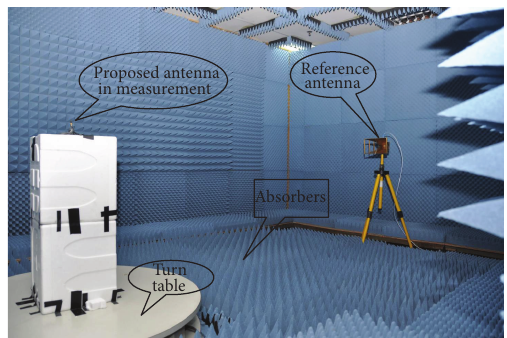
Figure 3: Illustration of the anechoic measurement